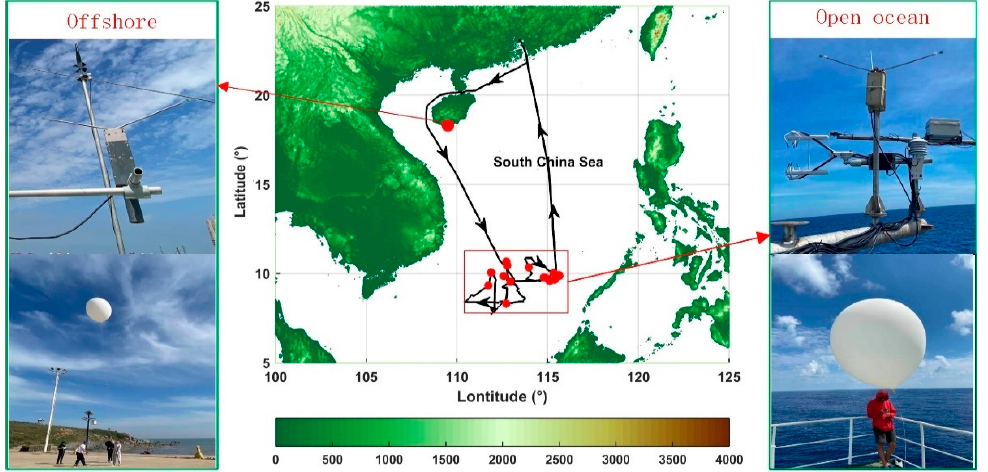
Figure 1. Photographs of a balloon-borne micro-thermometer and the micro-thermometer over the offshore ( left ) and open ocean ( right ).